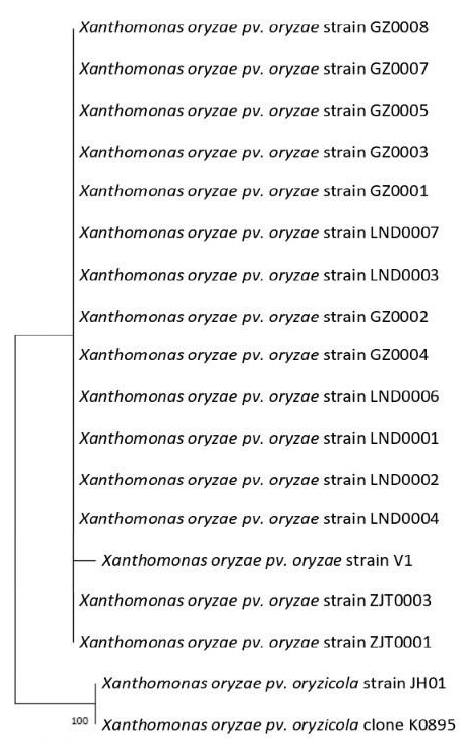
Figure 3. A neighbor-joining tree based on the nucleotide sequence of 16S rRNA. The 16S rRNA sequences of 50 Xoo were gathered from the NCBI (National Center for Biotechnology Information) database by a BLASTN search using the 1506 bp PCR products obtained from Xoo isolates. Table 4. Pathogenicity assay of Xanthomonas oryzae pv. oryzae isolates on rice cultivars. Lesion Length (cm) of Bacterial Leaf Blight on Selected Rice Isolate